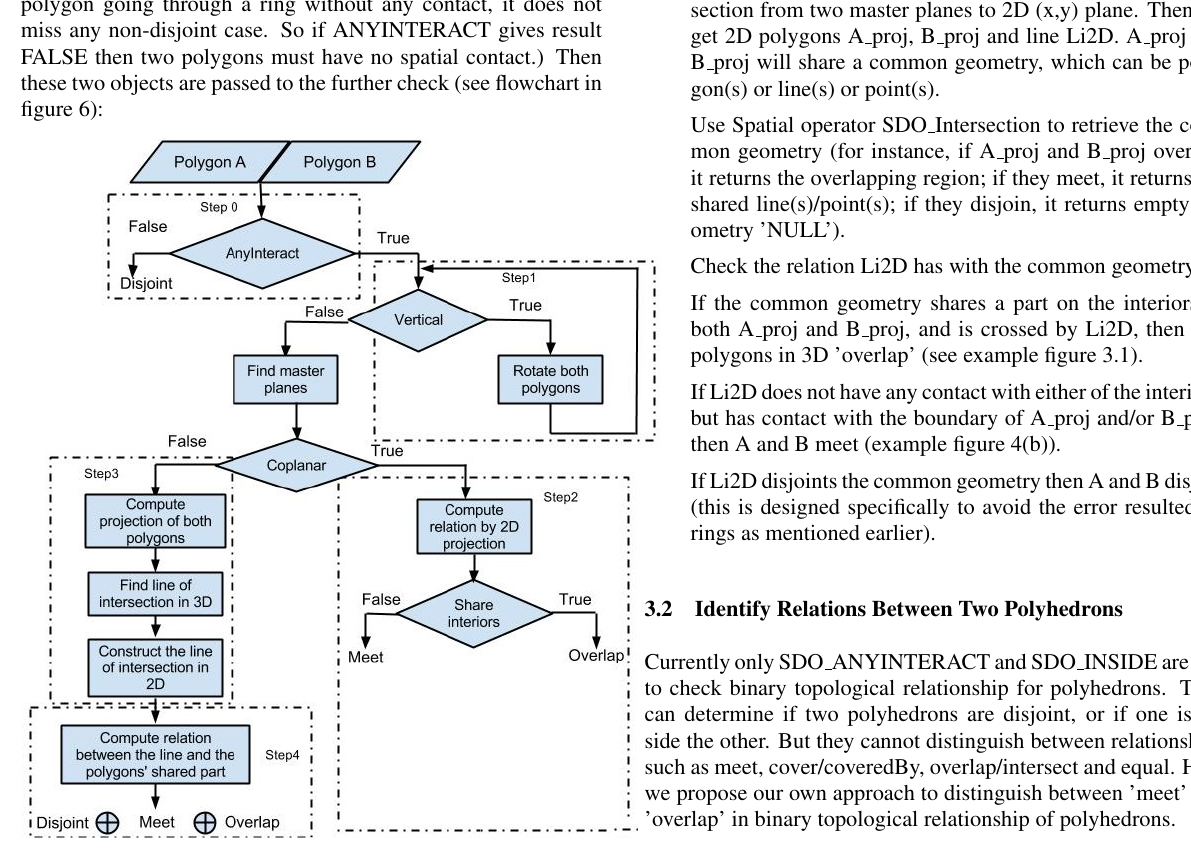
Figure 6: Flowchart of the algorithm determining topological re- lationships of interests between two 3D planar